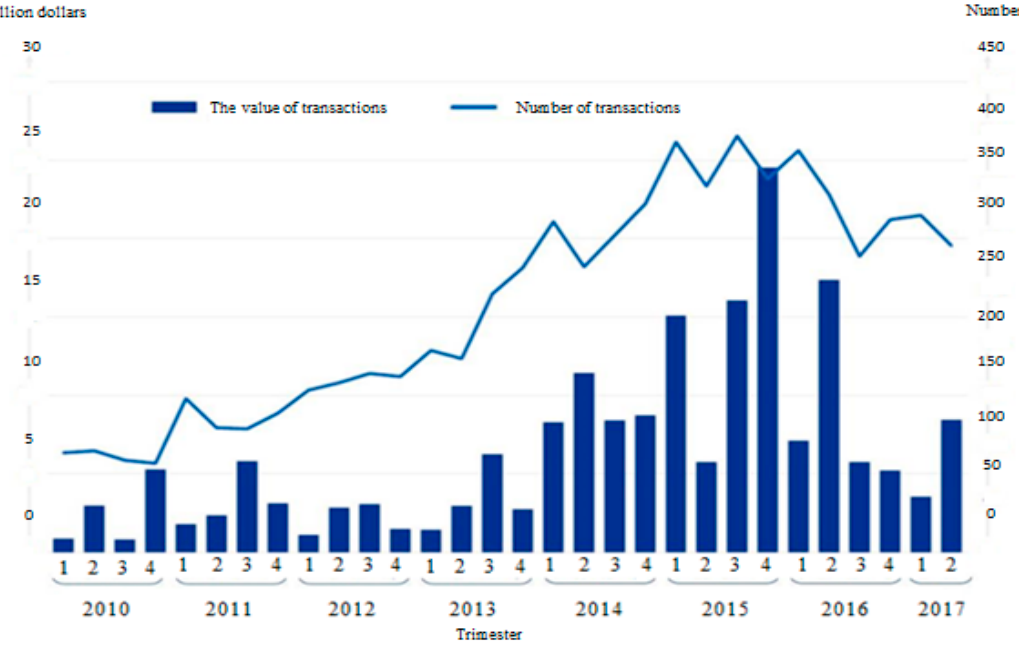
Figure 8. Investing in FinTech companies. Source: (KPMG 2017).